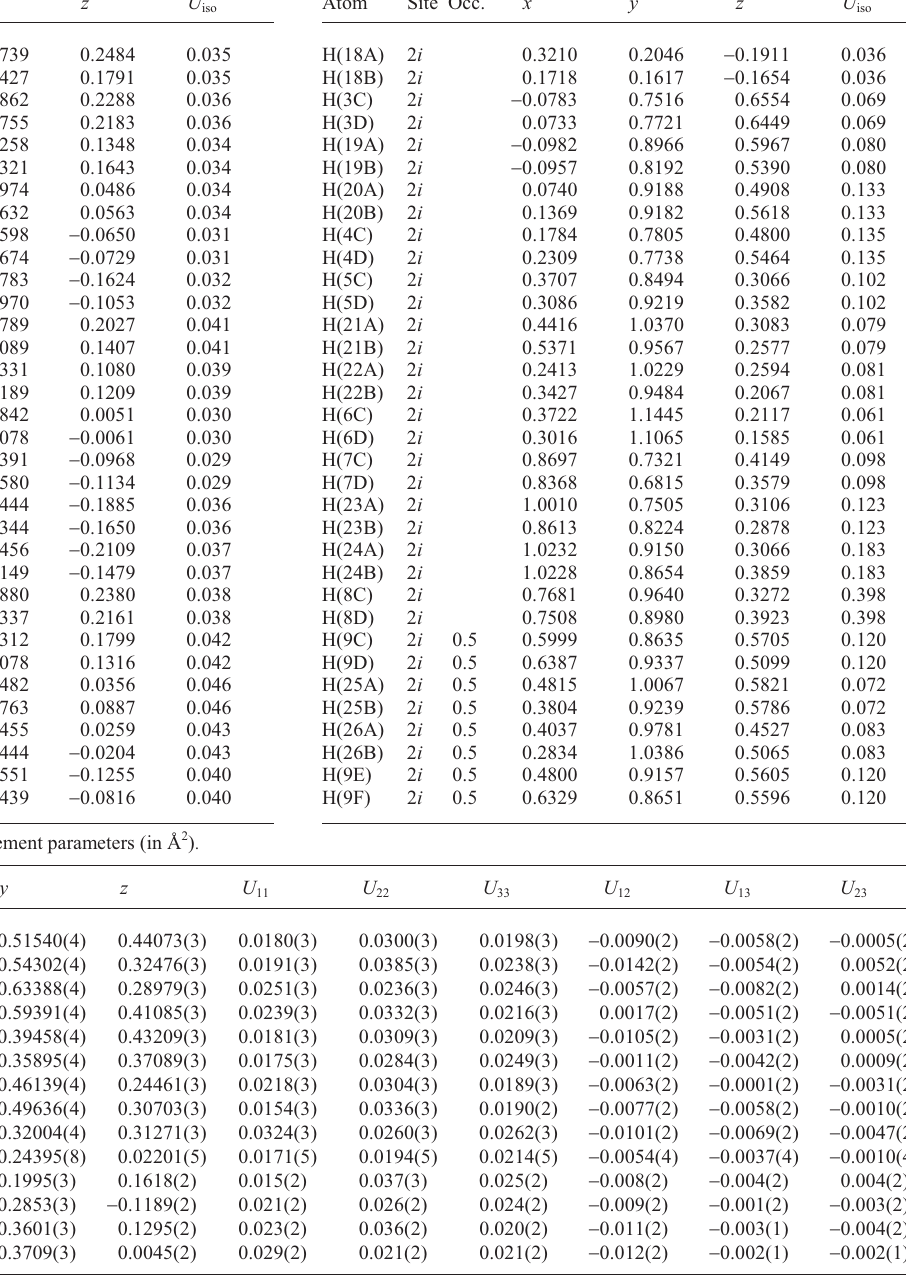
Table 2. Atomic coordinates and displacement parameters (in Å 2 ) . Atom Site Occ.